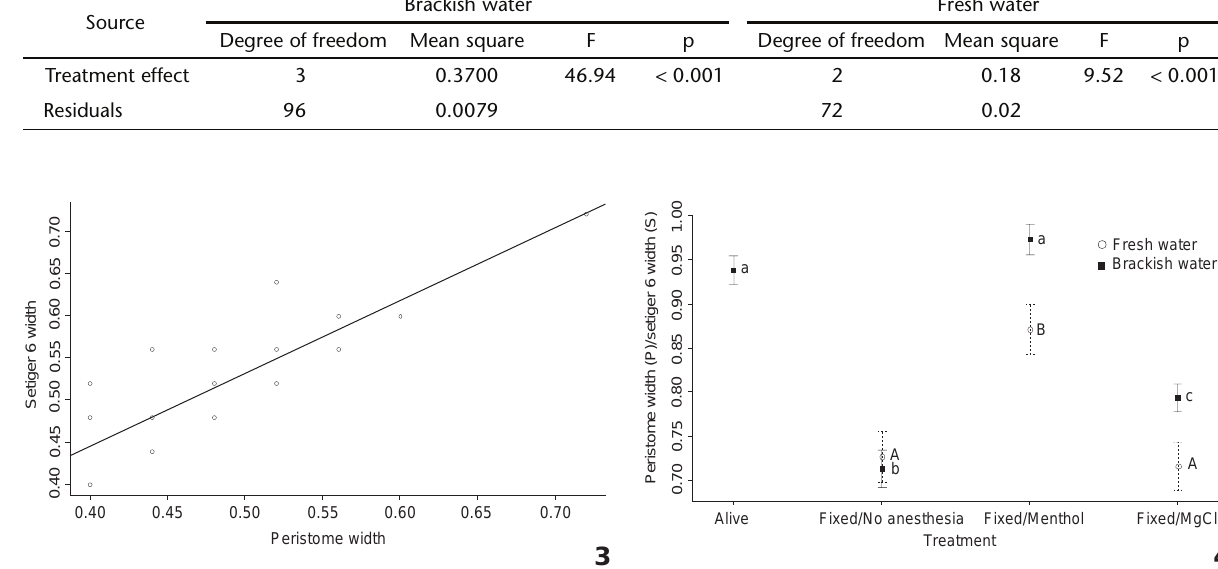
Alive Fixed/No anesthesia